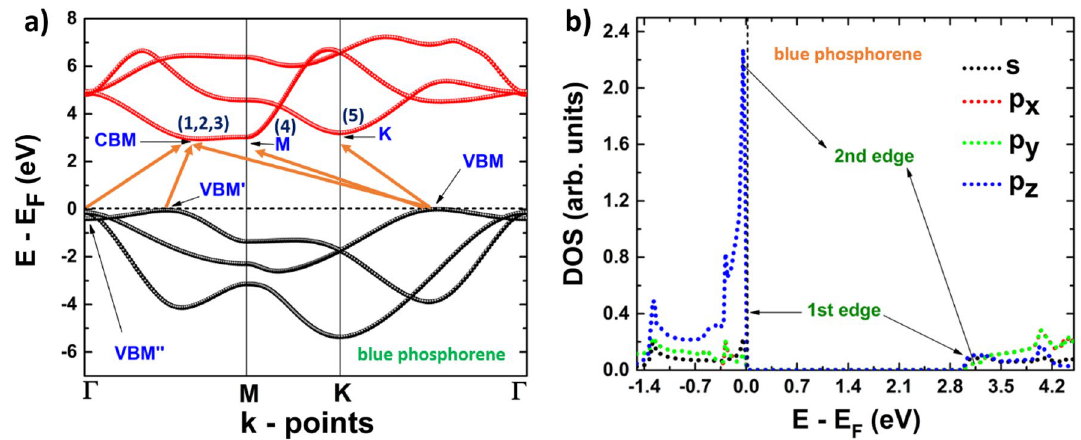
Figure 4. ( a ) Band structure;1, 2, 3, 4 and 5 refers to possible electronic transitions. ( b ) projected density of states of blue minima. Figure 4b is helpful to determine how the three valence bands are formed. The contribution to form these edges can be explained as follows: the first edge is located precisely at the Fermi level, and it is formed by s , p z , p x and p y -orbitals. The contributions of the second and third edges can be seen from the sharp peak formed by p z -orbitals located very close to the Fermi level. As seen in Fig. 4b, the energy difference between the Fermi level and the energy at which the sharp peak is located is very small, in agreement with the band structure. On the other hand, the first conduction band shows also three different edges, the first one, located at the CBM, comes from the contribution of p z -orbitals, while the second (located at M), and third (located at K) are formed by s , p x and p y -orbitals. With this information in mind, we can identify the first five electronic transitions from the last valence band to the first conduction band. These transitions are labeled as follows: 1 from VBM to CBM, 2 from VBM’ to CBM, 3 from VBM’’ (Γ) to CBM, 4 from VBM to M, and 5 from VBM to K. On the other hand, puk-P behaves as a direct band-gap semiconductor (see Fig. 5a), with valence band maxi- mum and conduction band minimum both located at the Γ point, giving place to electronic transition 1. There are two additional local minima in the first conduction band, one located at an intermediate point between Γ and Y, labeled as A, and the other at a point along Y and S, labeled as B. This fact makes possible the existence of two indirect transitions, from Γ to each local minimum (transitions 2 and 3). Figure 5b shows the orbital con- tributions to the bands, with the edge of the last valence band formed by p z -orbitals. The first conduction band is observed to have three different edges, the first located at Γ and formed by p z -orbitals. The second, located at A, and the third at B, are both formed by s , p x and p y orbitals. Let us now focus on the arsenene systems. Buk-As is also an indirect band-gap semiconductor, with the valence band maximum located at the Γ point and the conduction band minimum at an intermediate point